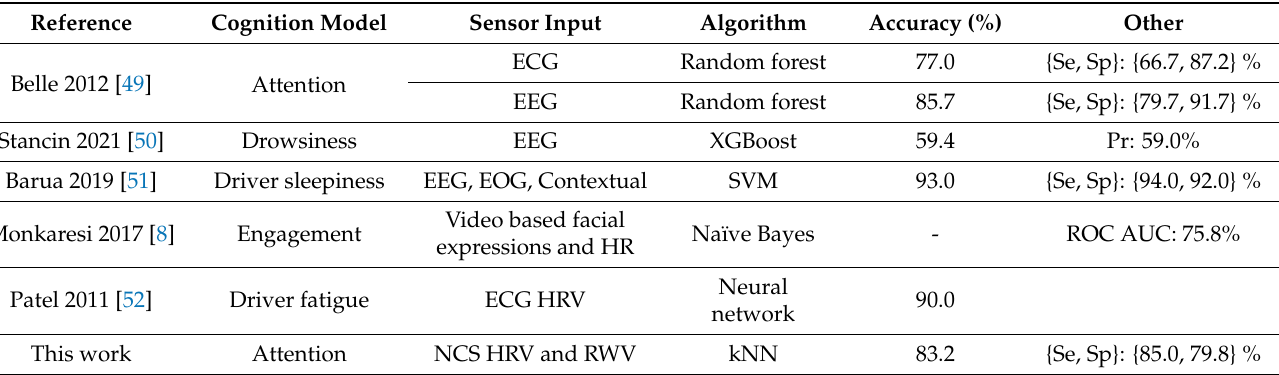
Table 4. Comparison of this work on attention and cognition monitoring with previous